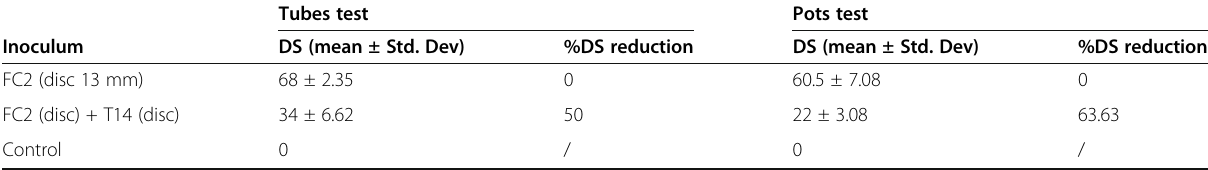
Table 3 Severity of FCR inoculated by FC2 and reduction percentage induced by T14, in both in vivo tube and pot tests Tubes